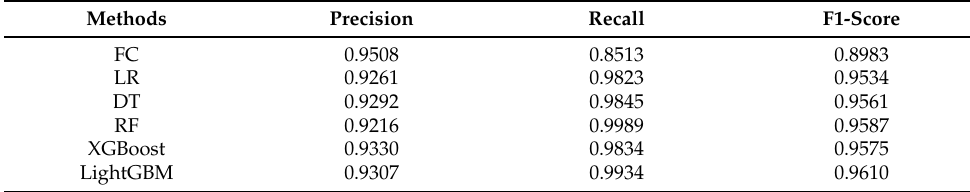
Table 4. Results of prediction using different